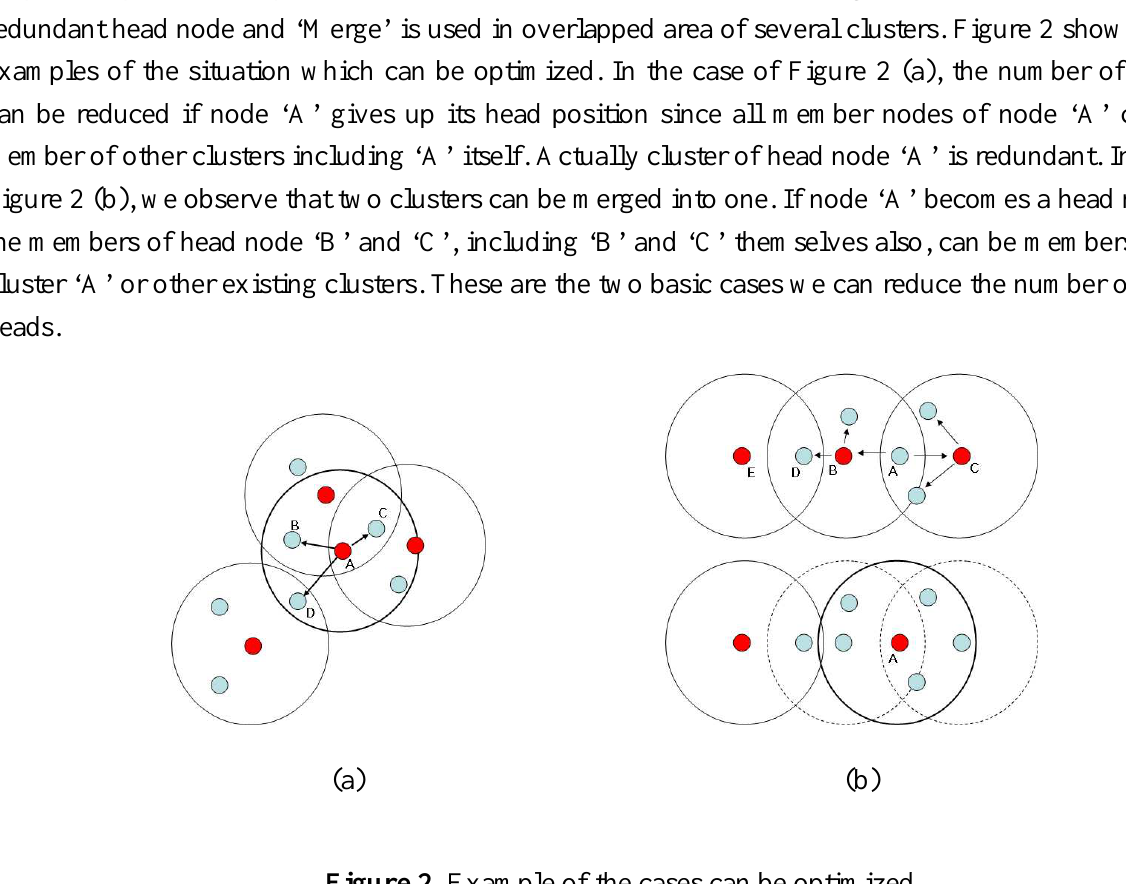
Figure 2. Example of the cases can be